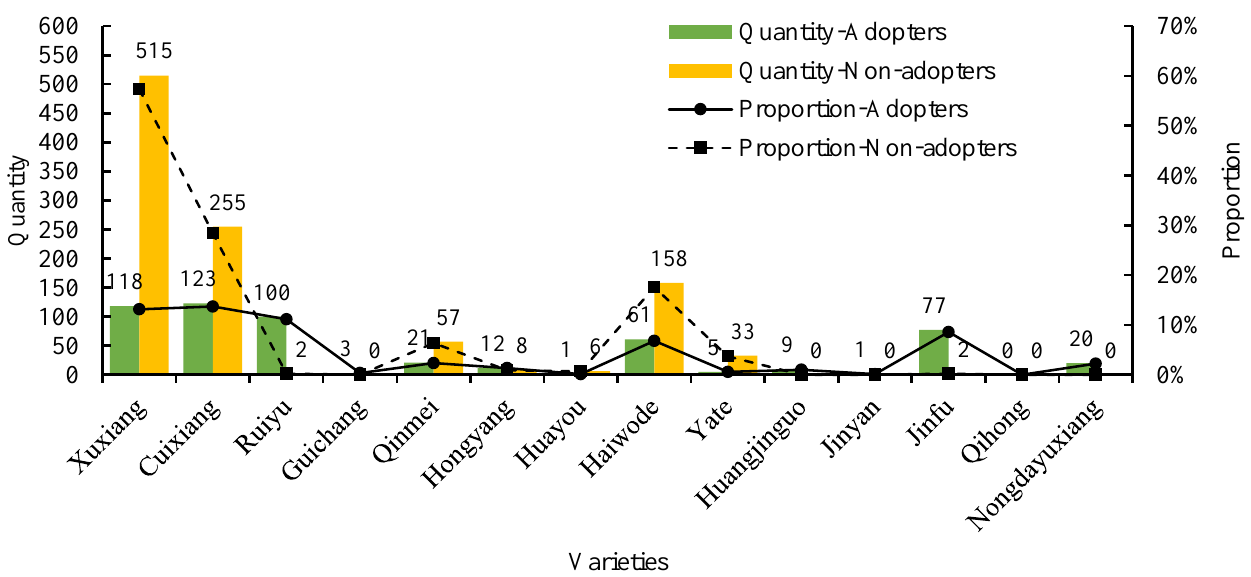
Figure 3. The quantities and proportions of adopters and non-adopters of new kiwi varieties. The farmers and producers were male-dominated in terms of decision making, with 580 male individuals in total, accounting for 64.5%. The average age of the farmers and producers was 52.12 years old, with the youngest being 30 years old and the oldest being 78 years old. A total of 60 people were under the age of 40, accounting for 6.6%. The largest